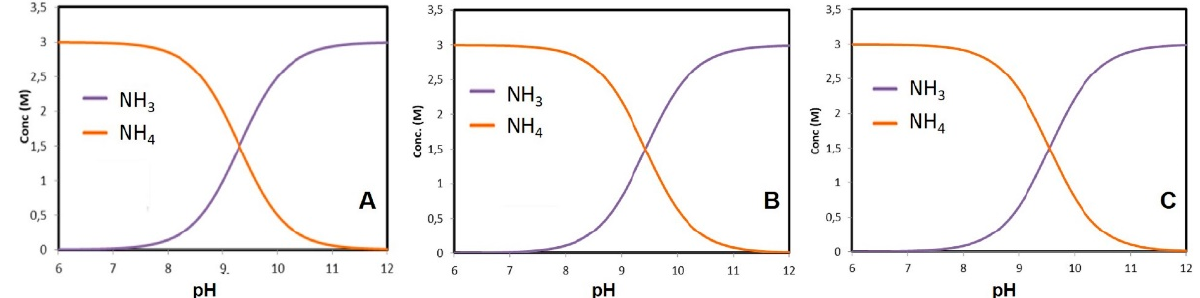
Figure 1. Distribution diagram of NH 3 /NH 4 + from varying the NH 3 –NH 4 + concentration of the solution in the presence of different ammonium salts, NH 4 Cl ( A ), (NH 4 ) 2 SO 4 ( B ) and (NH 4 ) 2 CO 3 ( C ).